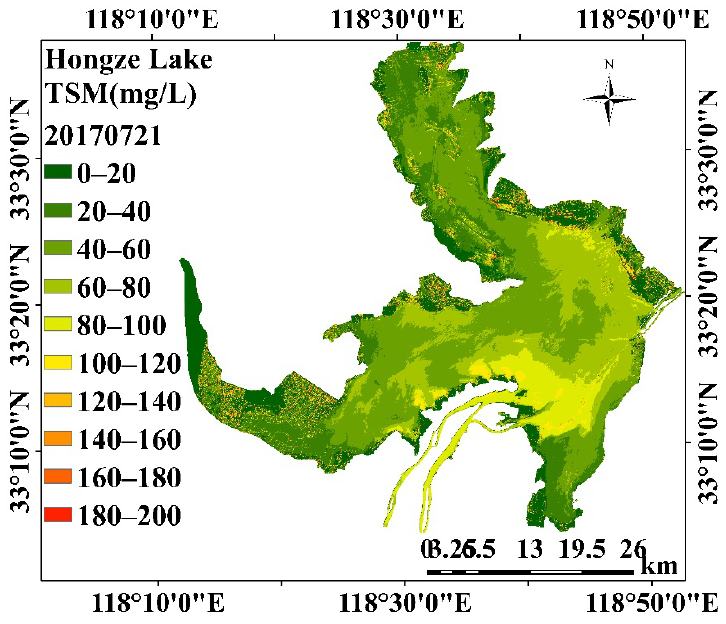
Figure 13. TSM distribution in the Hongze Lake on 21 July 2017.